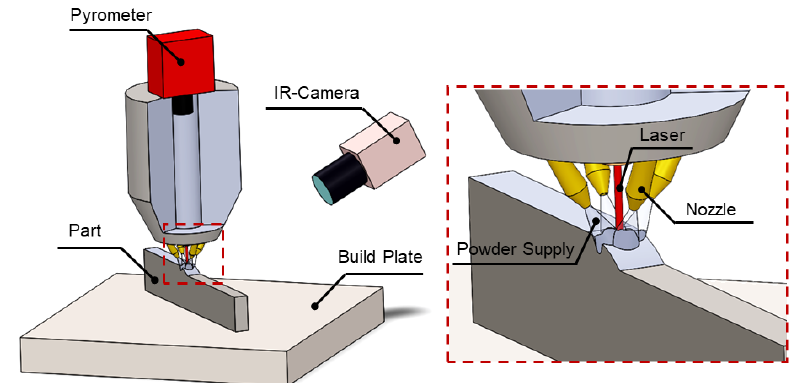
Figure 7. Directed Energy Deposition